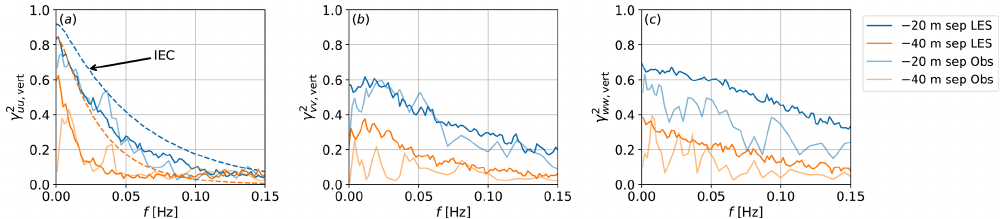
Figure 13. Comparison of coherence related to observed data for three turbulence components (a) u , (b) v , and (c) w of the wind speed separated vertically with respect to 80m. Negative separation means one point is below the reference point located at 80m, while positive separation means the second point is above the reference point. Dash-dotted curves shown are obtained from the IEC-recommended Kaimal spectrum with the exponential-coherence model, where defined.